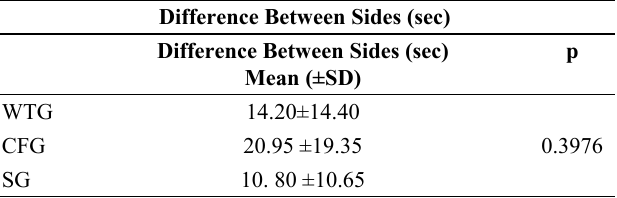
Table 3. Mean values and standard deviation of the groups consid - ering the difference between the non-dominant and dominant